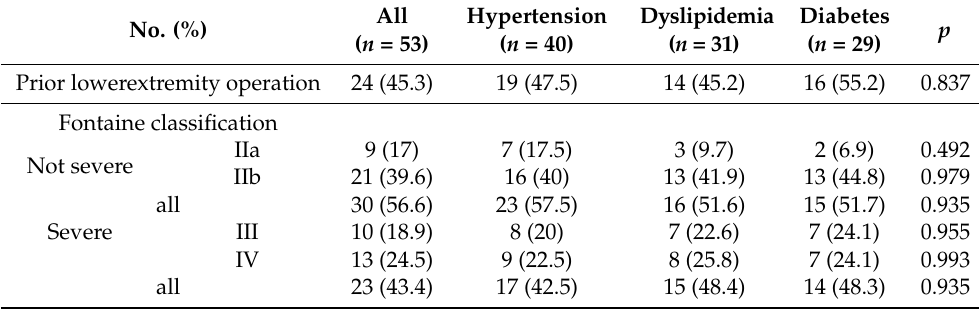
Table 2. Clinical characteristics for lower-extremity artery disease